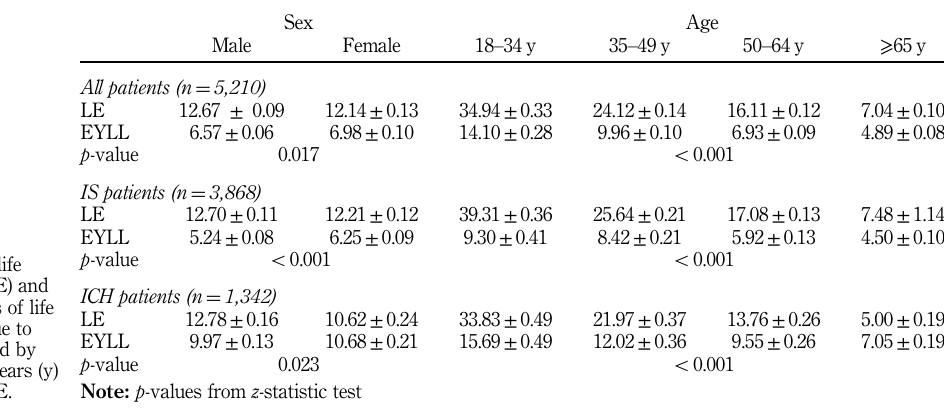
Figure 2. Survival curves of patients with ischemic stroke and Notes: The solid line represents the survival curves of patients with stroke, while the dotted line intracerebral hemorrhage and represents the survival curve of the general population in Thailand that was age- and sex-matched. their corresponding The area under the solid line represents the mean life expectancy (LE) and the shaded area referents between the two survival curves is the expected years of life lost (EYLL)